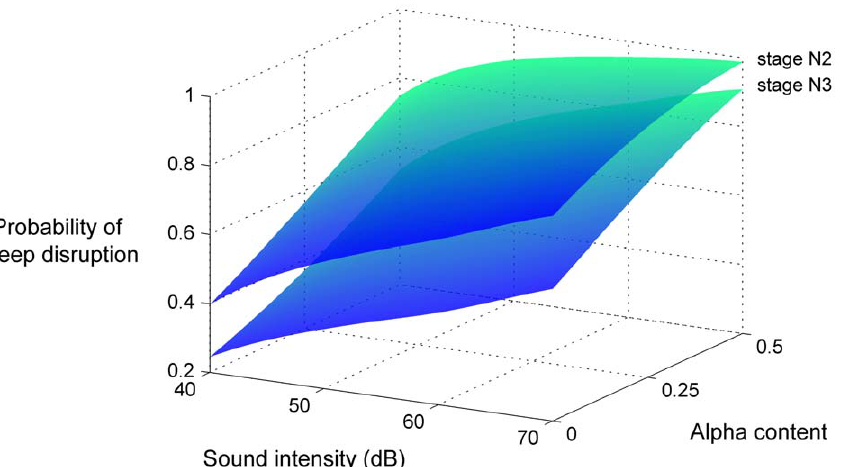
Figure 3. Alpha content reveals immediate sleep fragility. Using Cox regression, we found that alpha activity disclosed noise sensitivity during NREM sleep, even when controlling for stage. Here we reconstruct probability surfaces for sleep stages N2 and N3, rendering sleep fragility as a function of both stimulus intensity and EEG alpha content.